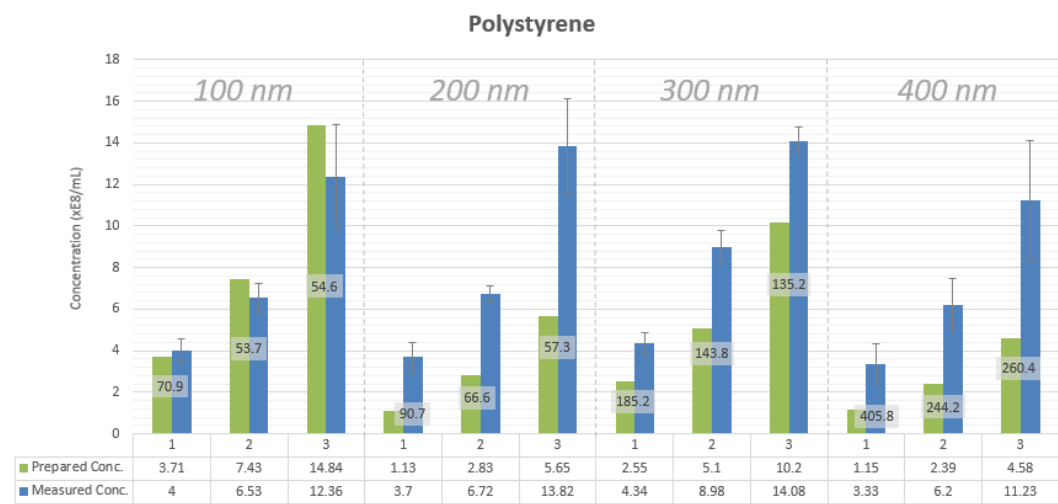
Figure 2. Concentration measurements of three prepared concentrations for different particle sizes for polystyrene nanoparticles as measured by NTA. Each sample of nanoparticles is measured in triplicate by three different researchers on three separate occasions, adding up to nine measurements for each sample. FWHM values for sample histograms are shown in nm in data labels.